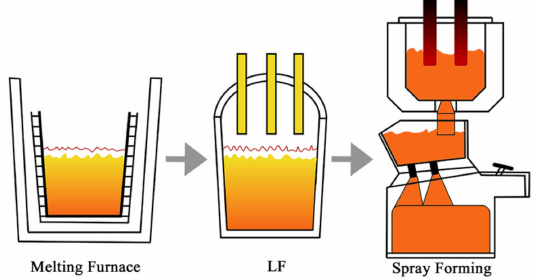
Figure 2. The production process for spray